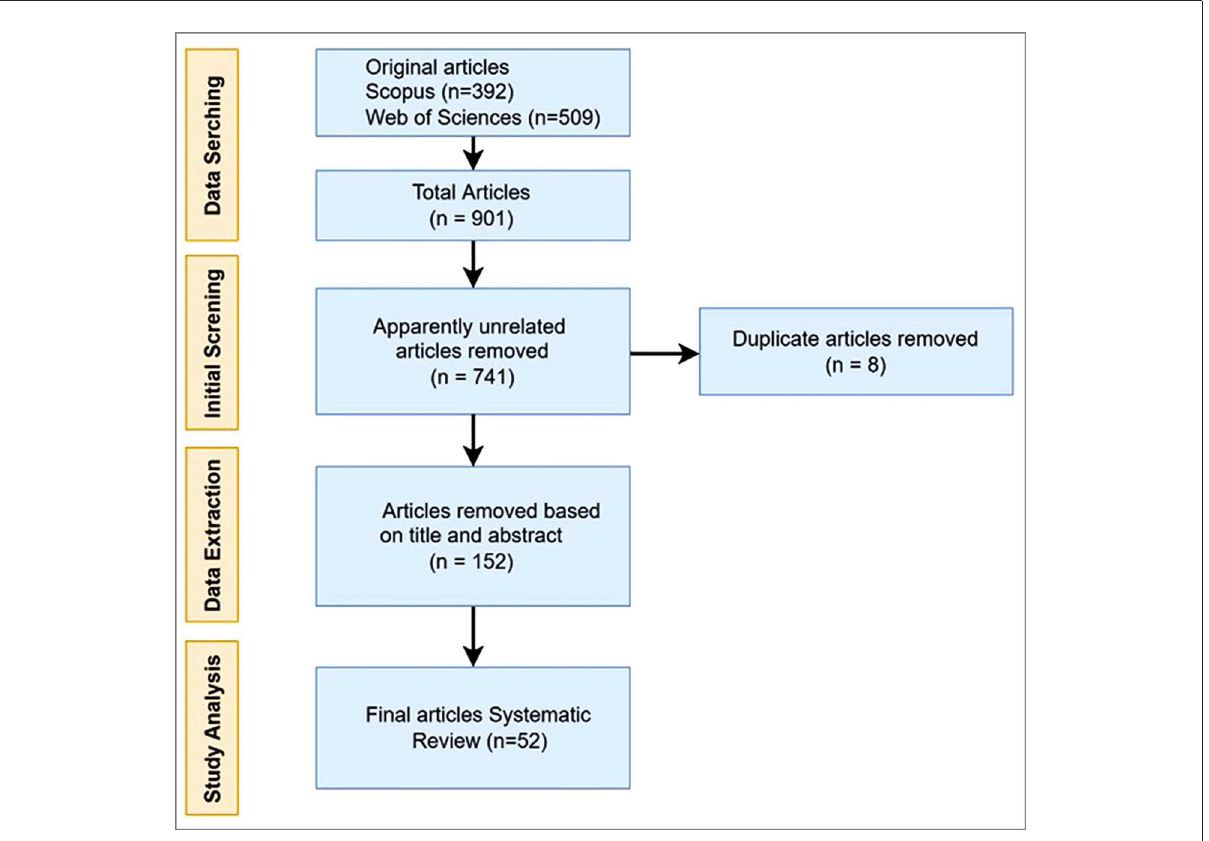
FIGURE1 The systematic literature review process.